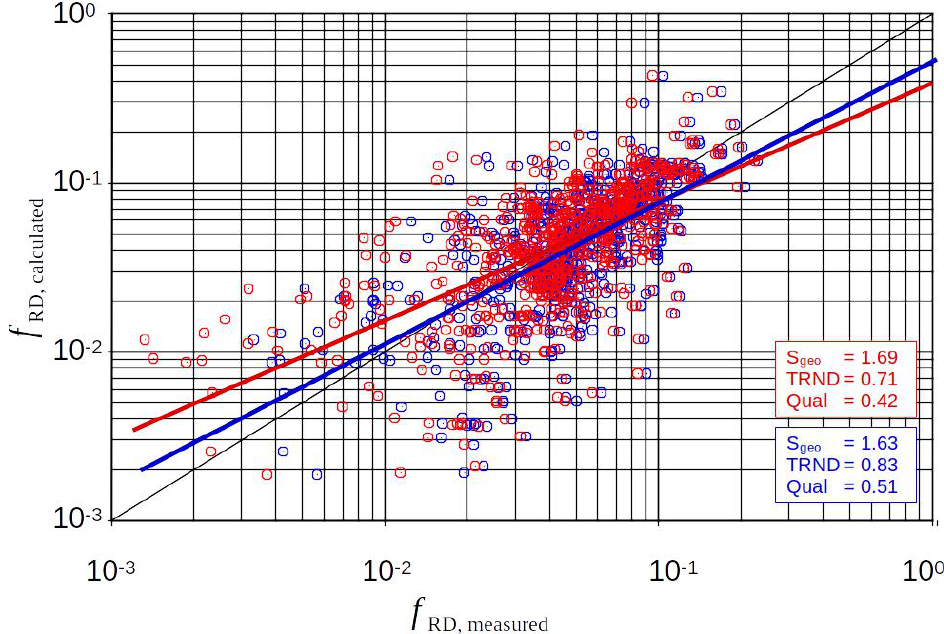
Figure 14. All data: The effects of the assumption for k S / d . Blue: k S / d = 1; Red: k S / d = 3. (Skin friction assumed as active on full length of the ripples and dunes and B = 8.5 in both